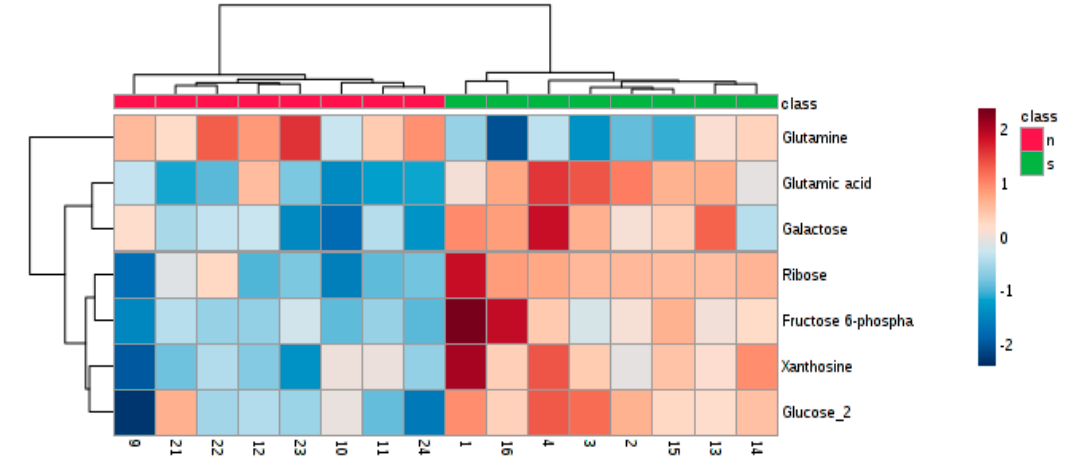
Figure 7. Heatmap for the comparison of two groups: treated with Zn NP (red color—n) and without the treatment method applied (green color—s).